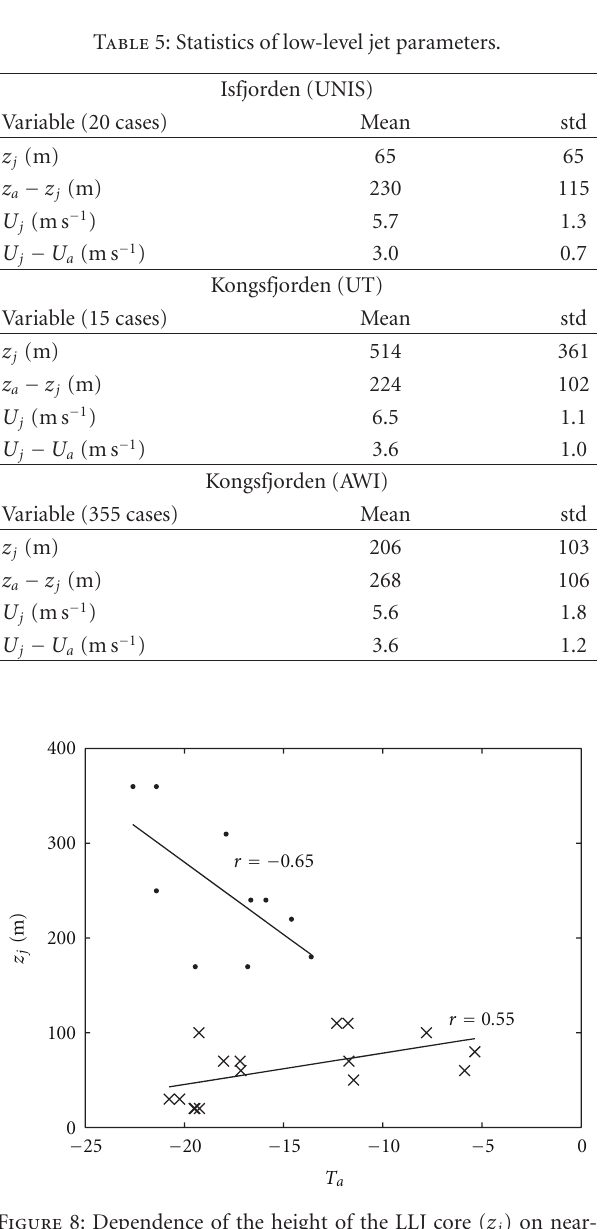
Figure 8: Dependence of the height of the LLJ core ( z j ) on near- surface air temperature ( T a ) in Isfjorden (crosses) and Kongsfjorden (dots).